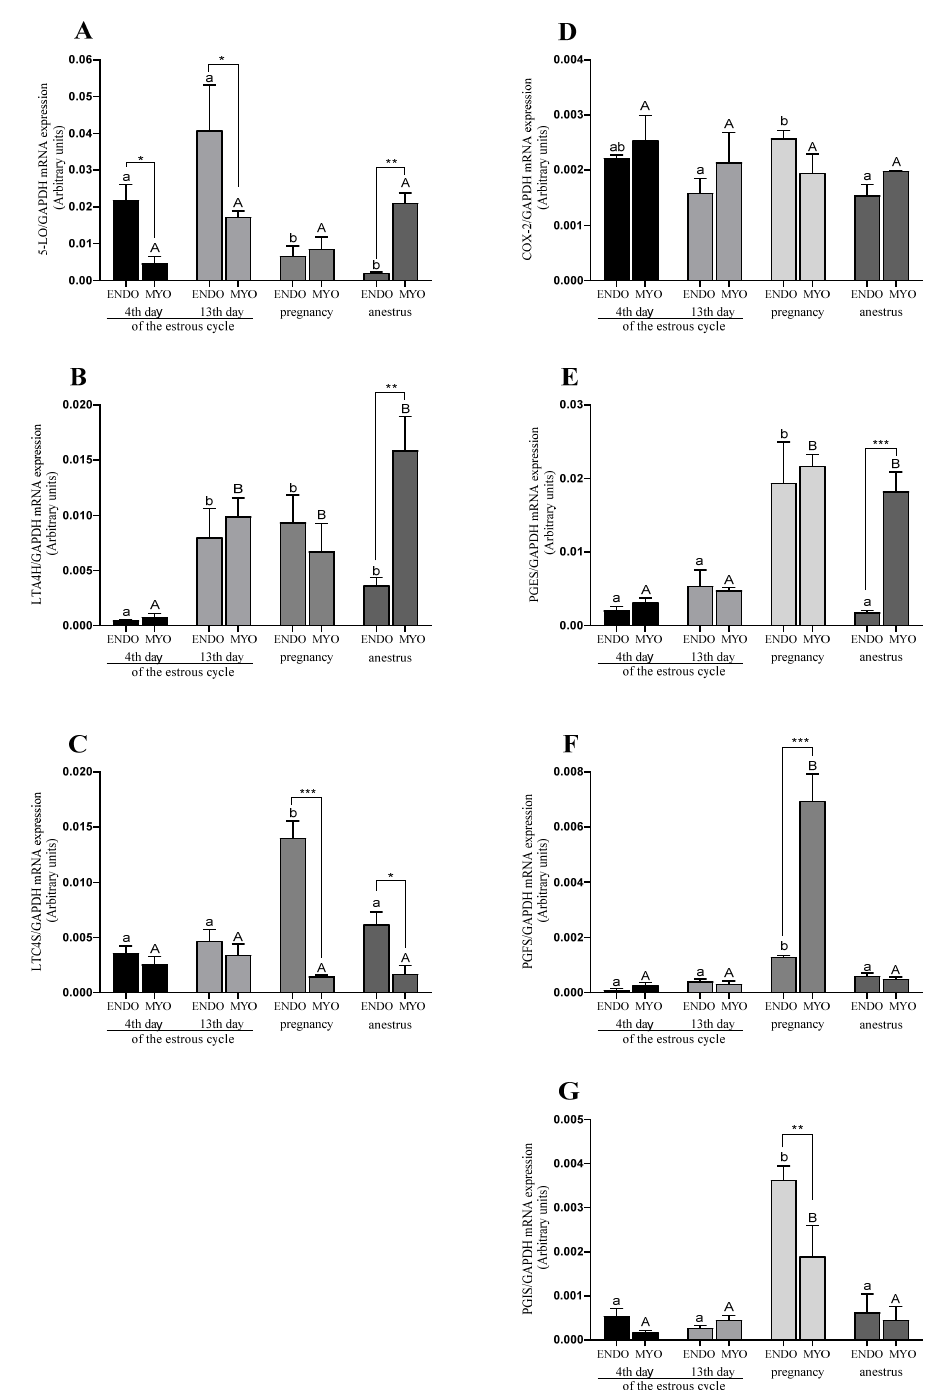
Figure 3. mRNA expression of 5-LO ( A ), LTA4H ( B ), LTC4S ( C ), PTGS2 ( D ), PGES ( E ), PGFS ( F ), and PGIS ( G ) in uterine tissues (endometrium and myometrium) on 4th and 13th day of the estrous cycle, and in pregnancy and anestrus phase. Data were normalized against GAPDH for mRNA expression using GraphPad PRISM (Version 8.3.0). Each bar represents one experimental group with SEM. Statistical differences were analyzed withy two-way analysis (ANOVA) of variance followed by Tukey’s post hoc test. The lowest statistical significance was p < 0.05. Asterisks indicate statistical differences between endometrium and myometrium (* p < 0.05; ** p < 0.01; *** p < 0.001). Different letters indicate statistical differences ( p < 0.05) between the experimental reproductive stages throughout endometrium (a, b) and myometrium (A, B), respectively.